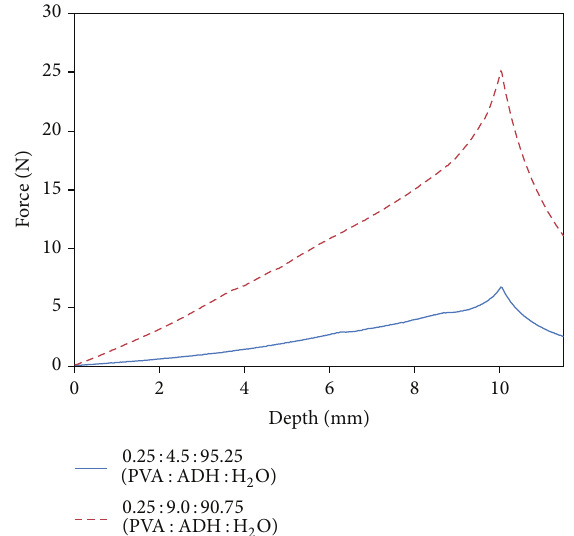
Figure6:Forcecurvesofthecylindricalplungersensorinintruding PVA hydrogel over time down to 10 mm in depth.